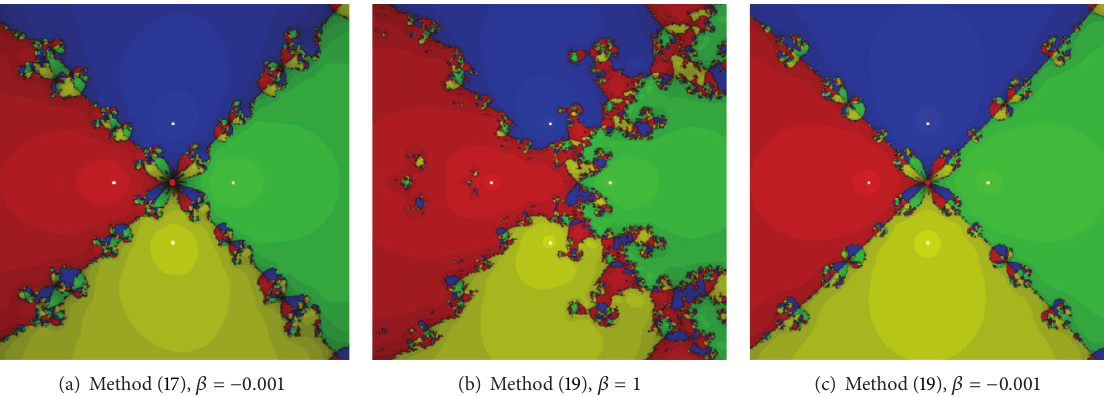
Figure 18: Basins of attraction for the test problem 1.